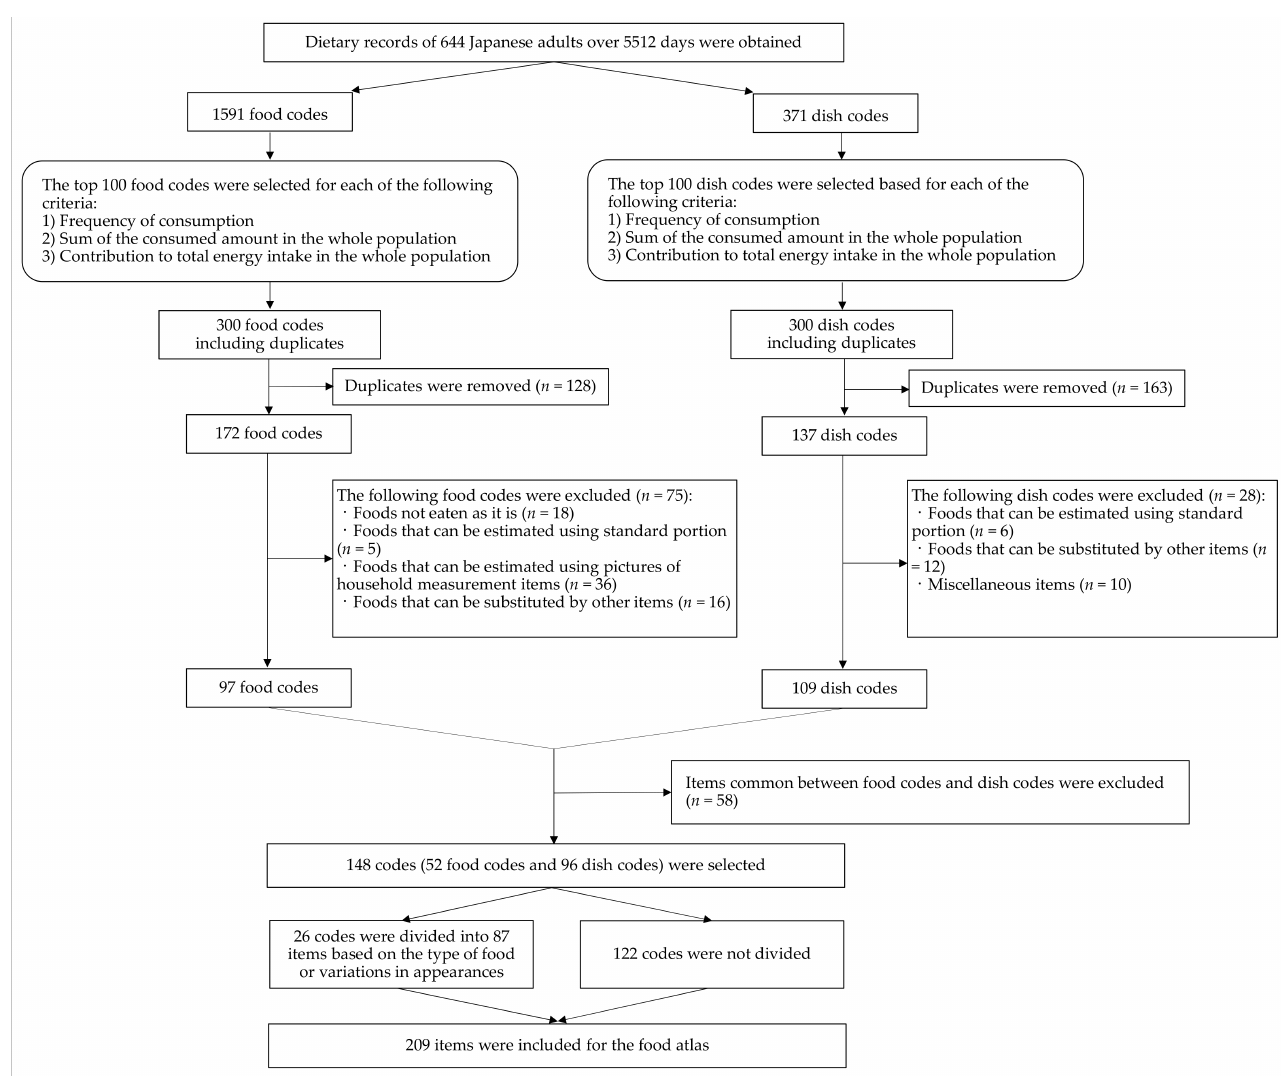
Figure 1. Selection flow of the foods and dishes for the food